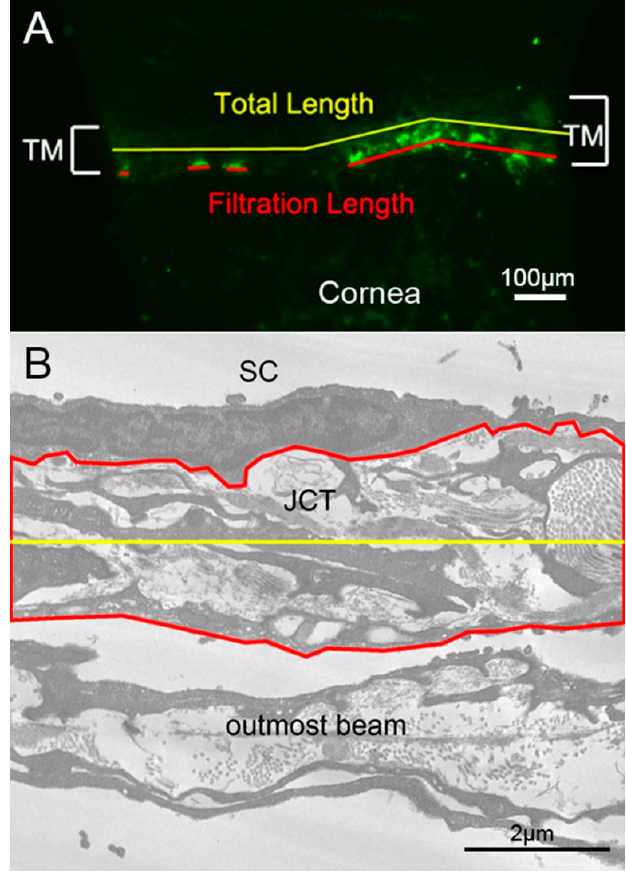
Figure 11. Measurement Methods for TM PEFL and JCT Thickness. ( A ) Methods of trabecular meshwork percentage effective filtration length (TM PEFL) measurements. The tracer distribution is shown in green. The red lines represent effective filtration length (FL) labeled with fluorescent tracers, while the yellow line represents the total length (TL) of trabecular meshwork (TM). The average TM PEFL in each perfused mouse eye was calculated as TM PEFL= Σ FL/ Σ TL × 100%. ( B ) Methods of Juxtacanalicular Tissue (JCT) thickness measurements. JCT area (red) and JCT length (yellow) were measured in an electron microscopic image, with the average JCT thickness ( Σ JCT area/ Σ JCT length) calculated accordingly.